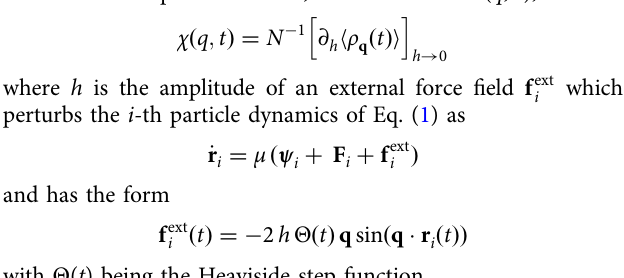
Fig. 3a corresponding to the largest system with N = 60 × 10 3 ) yields z = 3.78(0.13) for the response and z = 3.80(0.14) for the correlator (the fi t error is reported in brackets), which are